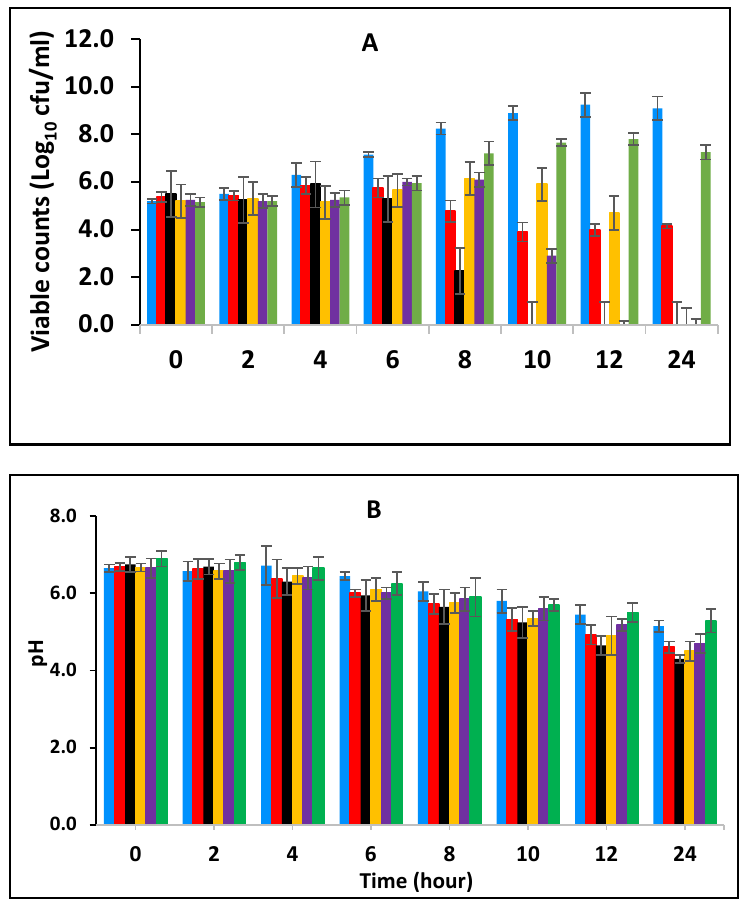
Figure 2. Growth of E. fergusonii ( A ) and change in pH ( B ) in fermenting milk in the presence of essential oils of black pepper (BPE) and cinnamon extracts (CE) at different concentrations at 43 ◦ C for 24 h. Concentrations are in % ( w / v ), values are the mean of three individual replicates (means ± SD). Control [ (cid:4) ]; 0.5% BPE alone [ (cid:4) ]; 0.1875% CE + 0.125% BPE [ (cid:4) ]; 0.125% CE + 0.25% BPE [ (cid:4) ]; 0.0625% CE + 0.375% BPE [ (cid:4) ]; 0.25% CE alone [ (cid:4)